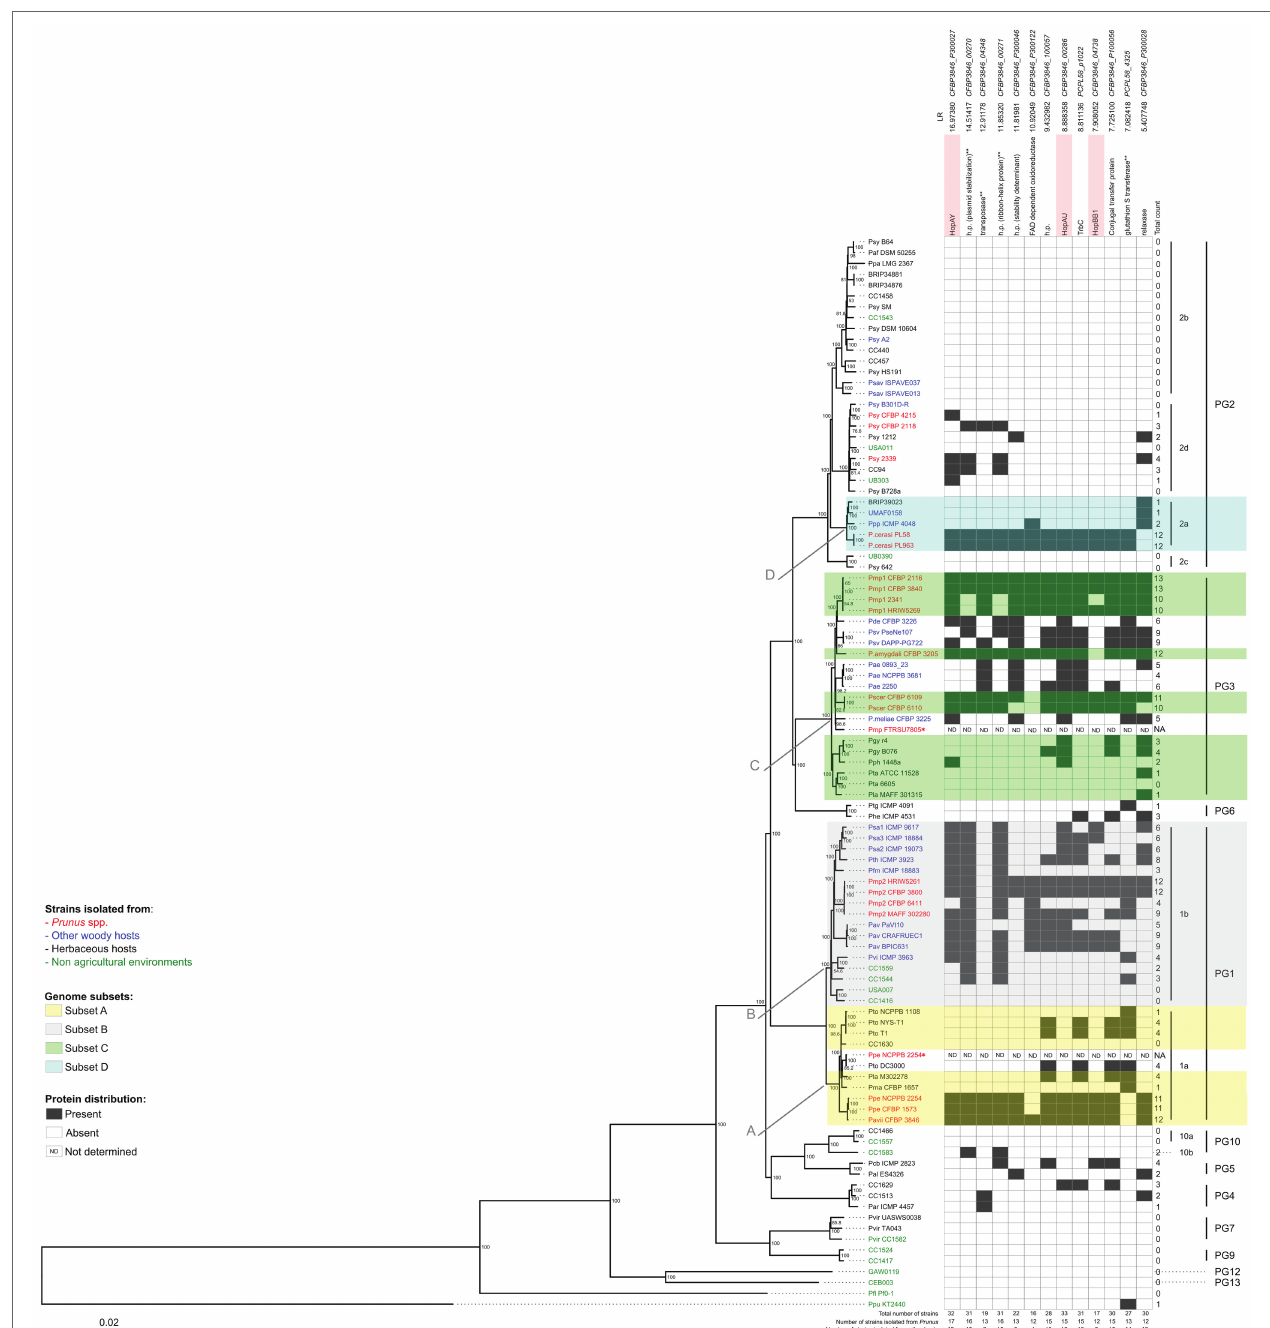
FIGURE 1 | Neighbor-joining (NJ) phylogeny based on the core genome of the Pseudomonas syringae species complex and distribution profile of 13 proteins considered to be significantly associated with Prunus spp. among these strains. A set of 99 genomes of strains belonging to the P. syringae species complex as well as one Pseudomonas fluorescens and one Pseudomonas putida strains were used for this analysis ( Table 1 ). The tree was built using EDGAR 2.2 (Blom et al., 2016) out of a core genome of 1 , 344 CDS giving a total alignment of 5,36 , 722 amino acids per genome. Percent bootstrap (bt) support values calculated for 500 reiterations are indicated near nodes. Only bt values over 51 are displayed. The strain names refer to the code field from Table 1 . Phylogroups (PG) and clades are indicated on the right. Strains isolated from Prunus spp. are indicated in red, from other woody hosts in blue, from herbaceous hosts in black, and from non- agricultural environments in green. Strain names followed by an asterisk (*) indicate strains which were excluded from further comparative analyses due to a presumed misnaming of the genome. Genome subsets (A-D) used to determine the correlation between gene presence and Prunus spp. association are indicated with color highlights. Arrows indicate the node at which Prunus -associated strains are diverging from the non- Prunus -associated strains within the same genome subset. Protein orthologs were retrieved out of these 97 genomes using EDGAR 2.2 (Blom et al., 2016). Black squares indicate presence of the protein based